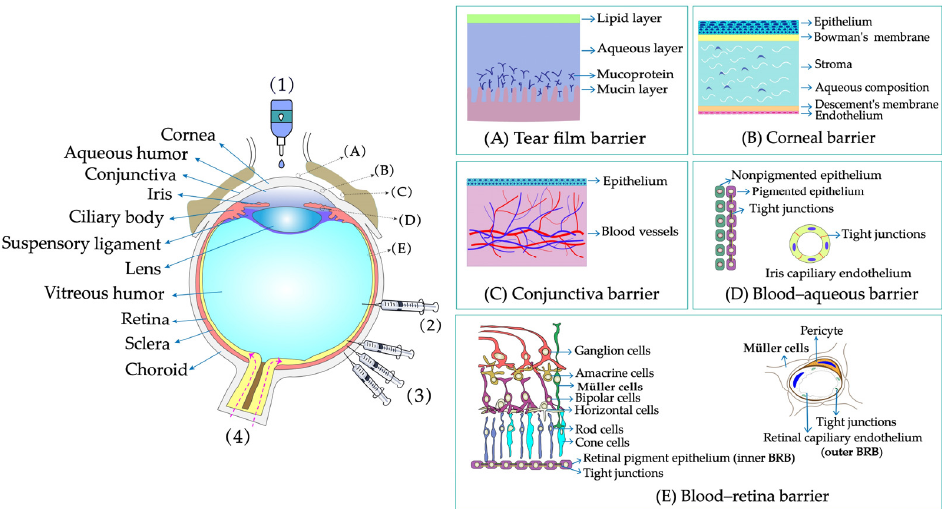
Figure 1. Structures of the eye, routes of drug delivery to the eye, and ocular barriers to drug delivery. The structures of the eye from the outside to the inside are the conjunctiva, cornea, aqueous humor, iris, ciliary body, lens, suspensory ligament, vitreous humor, sclera, choroid, and retina. Routes of ocular administration include (1) topical administration; (2) vitreous injection; (3) periocular injection; and (4) systemic administration. The main barriers to ocular administration consist of ( A ) the tear film barrier: composed of lipid, aqueous, and mucin layers. Acts as a defensive barrier against the entry of foreign objects into the cornea and conjunctiva; ( B ) the corneal barrier: consists mainly of endothelium containing tightly connected epithelial cells, water-soluble stroma, and a single layer of endothelial cells. Acts as a barrier to prevent the absorption of drugs from the tear fluid into the anterior chamber after topical administration; ( C ) the conjunctival barrier: a mucous membrane consisting of the conjunctival epithelium and underlying vascular connective tissue. Ab- sorption area is larger than that of the cornea, and drugs are easily absorbed into the body circula- tion through capillaries; ( D ) the blood–aqueous barrier (BAB): located in the anterior segment of the eye. Formed by the iris capillary endothelium and the nonpigmented epithelium of the ciliary body, both of which contain tight junctions. Prevents the passage of drugs from the blood (systemic) into the aqueous humor; and ( E ) the blood–retinal barrier (BRB): located in the posterior segment of the eye. Formed by the retinal pigment epithelium (outer BRB) and the endothelial membrane of the retinal blood vessels (inner BRB), both of which contain tight junctions. The tight junctions restrict the entry of the drugs from the blood (systemic) into the retina/aqueous humor.